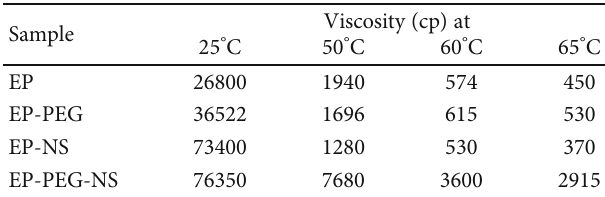
Table 6: The e ff ect of temperature elevation on the viscosity of